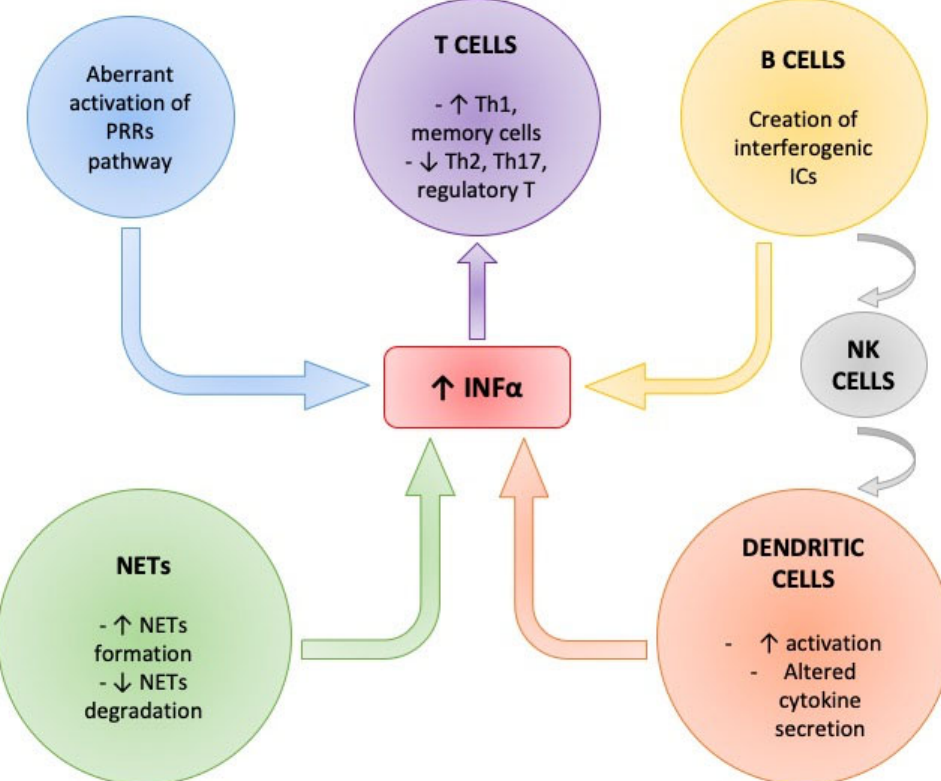
Figure 1. Summary of the main regulators of INF α in